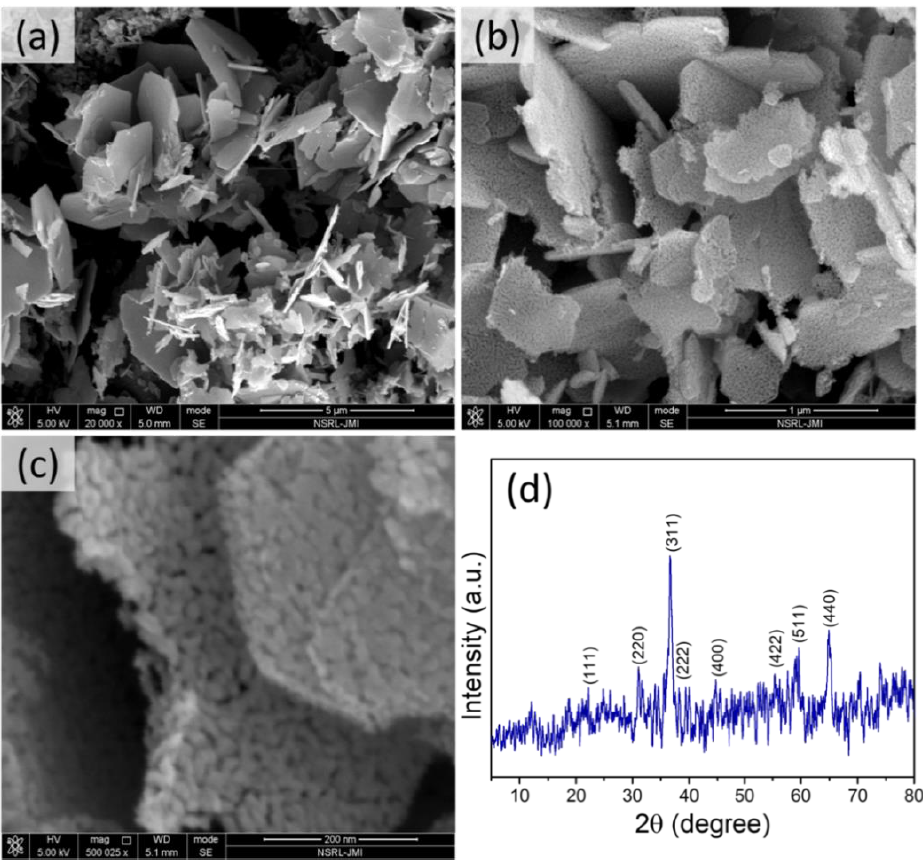
Figure 1 . FESEM images at low- ( a , b ) and high- ( c ) magnifications and XRD analysis ( d ) of porous cobalt oxide nanostructure.